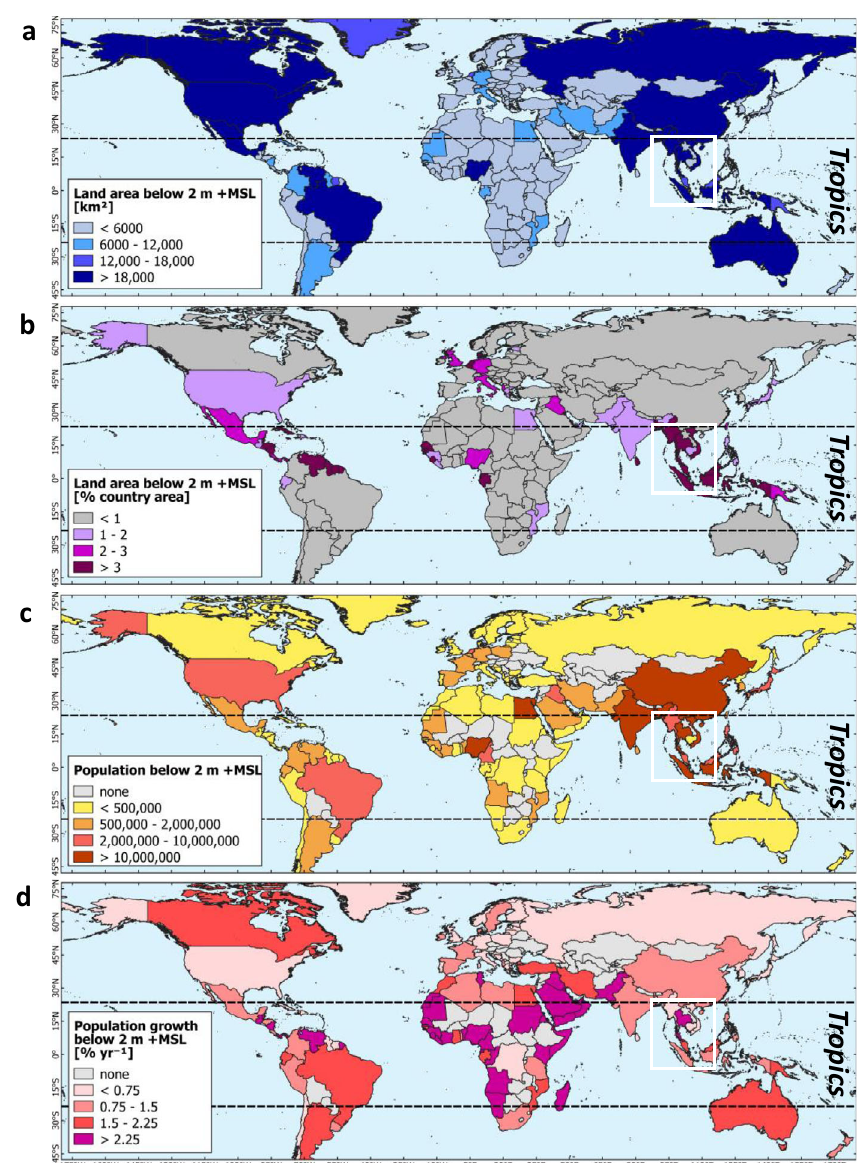
Fig. 1 Global distribution of countries with lowland area below 2 m above mean sea level ( + MSL) and population. a Absolute and b relative coastal land areas, c population size and d population growth. Lowland elevation of the tropical Asia central region as indicated in white box is shown in Fig.